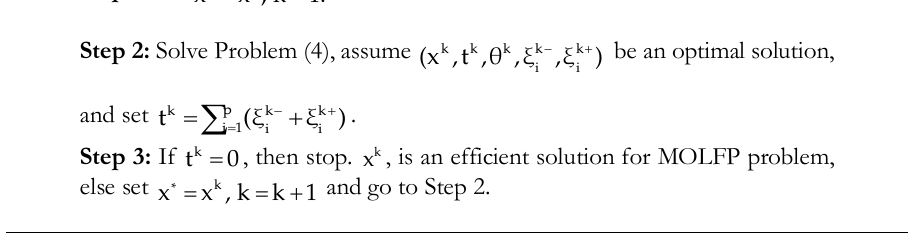
Algorithm 1. Obtaining efficient solution